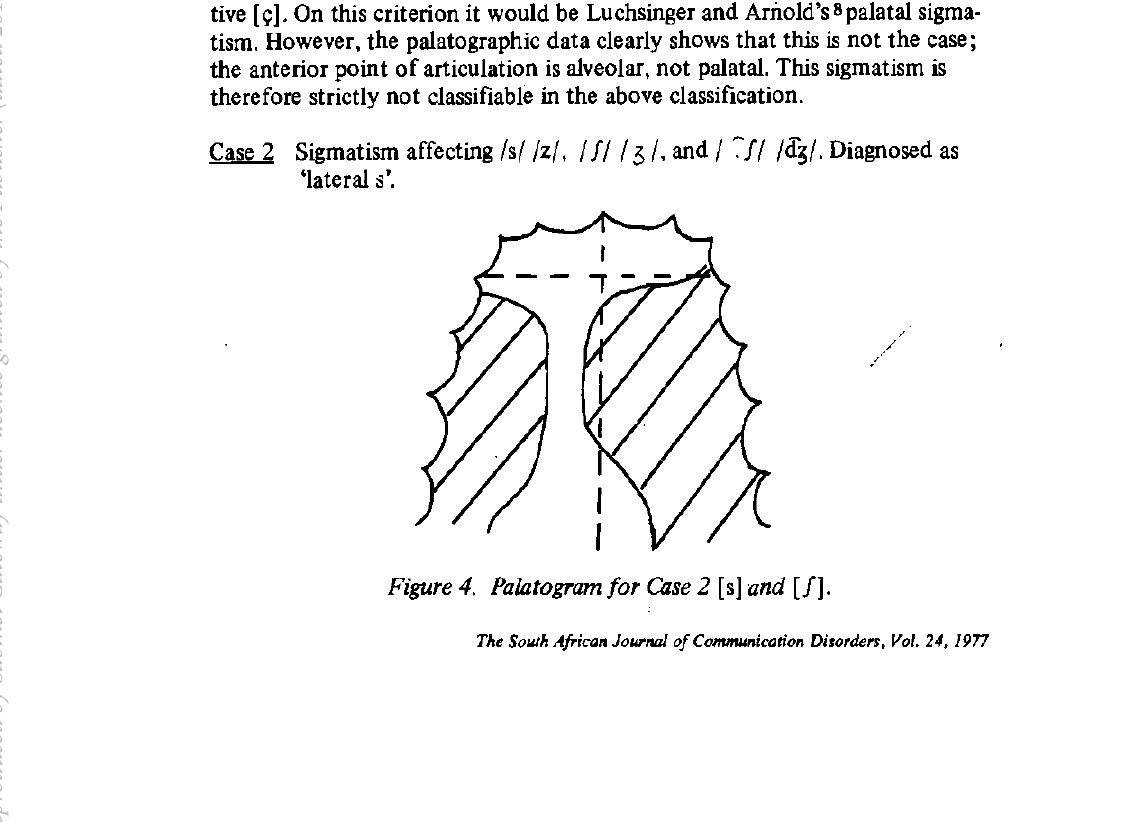
Figure 3. Palatogram for normal [s].